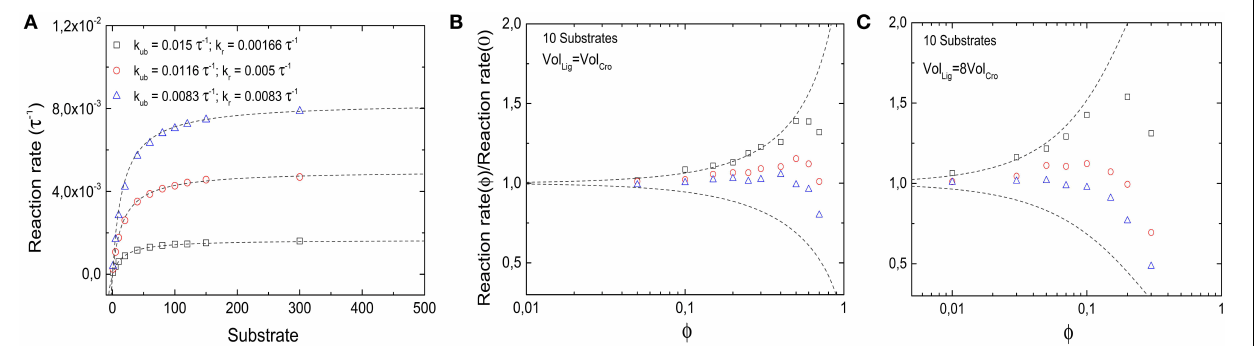
FIGURE 8 | Effects of molecular crowding on a reaction with Michaelis-Menten kinetics. (A) Overall product synthesis rate in absence of crowding ( φ 0 ) as a function of the number of substrates for different set = of parameters k ub and k r (in units of the inverse simulation time steps τ − 1 , all other parameters are as in Figure 2 ). (B) Ratio between the overall synthesis rate in the presence of crowders and the overall synthesis product rate without crowding as a function of crowder volume fraction φ . Non-monotonic behavior is obtained for all sets of parameters. For small values of φ , binding